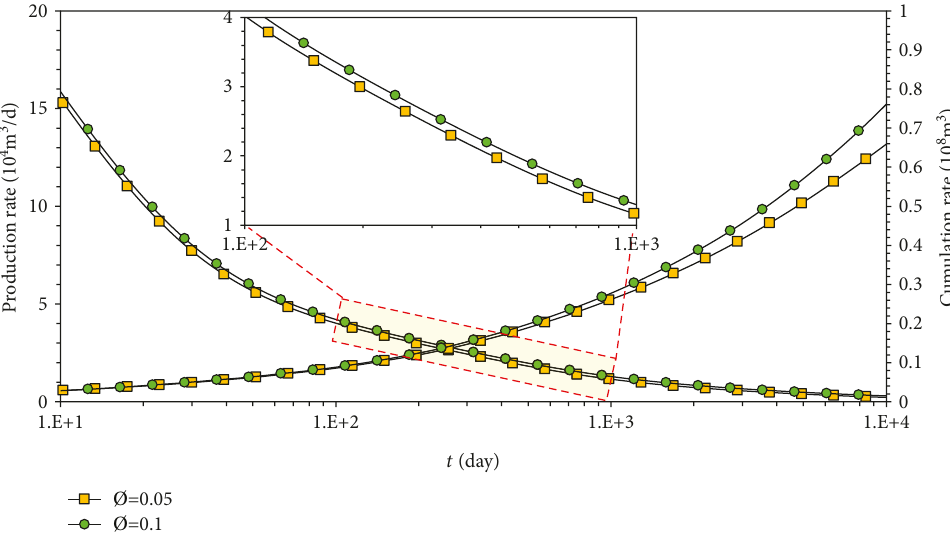
Figure 12: In fl uence of porosity in macropores on well production